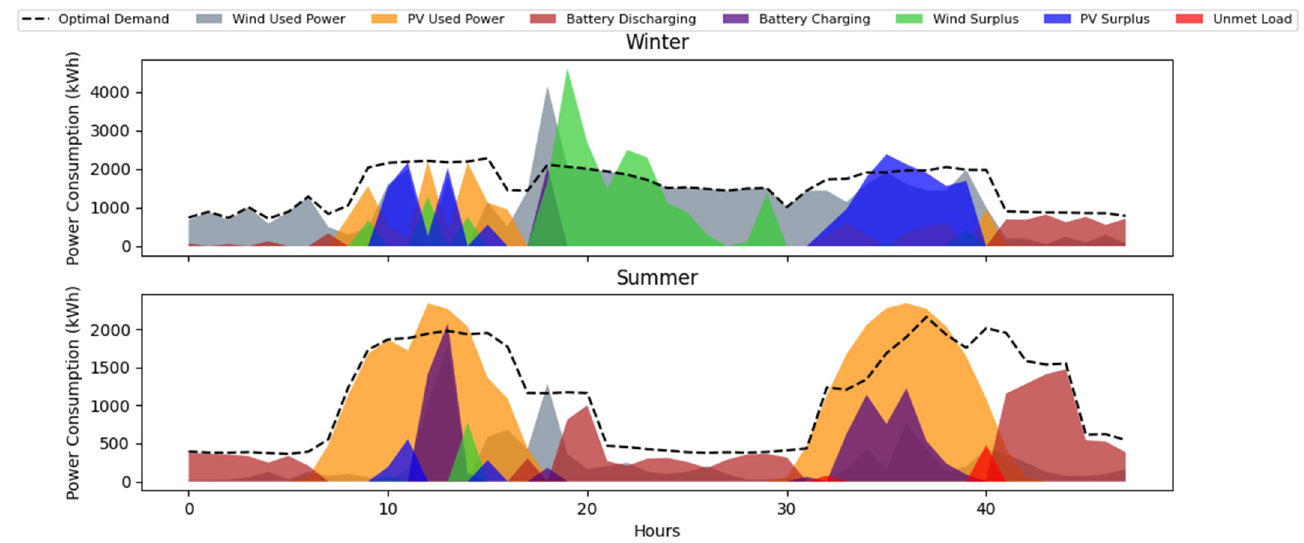
Figure 7. Optimal Schedule using optimal load demand.